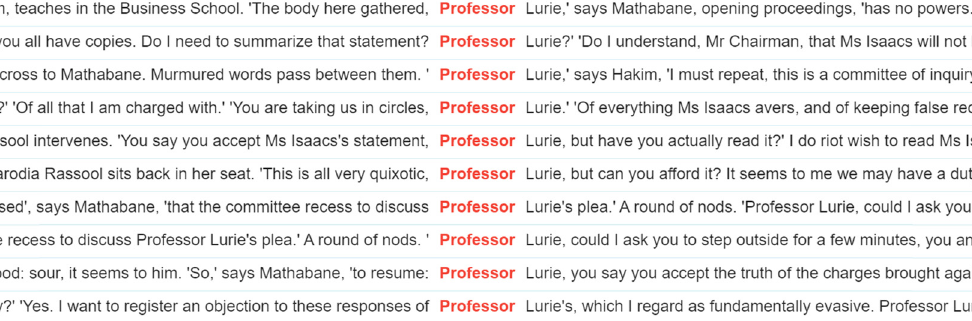
Figure 2: The keyword professor in concordance